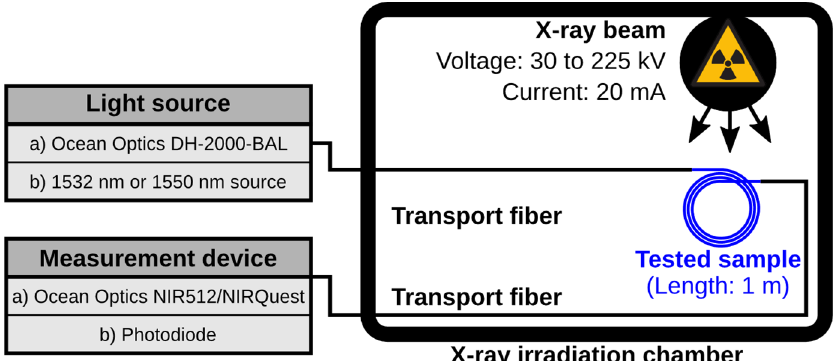
Figure 1. Simplified schematic of a typical X-ray tube and of the coordinate system of this study.